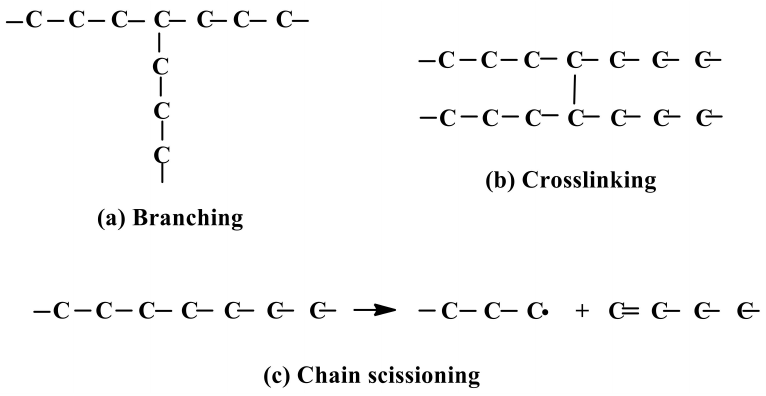
Figure 5. Scheme of chain branching, cross-linking, and chain scissioning.